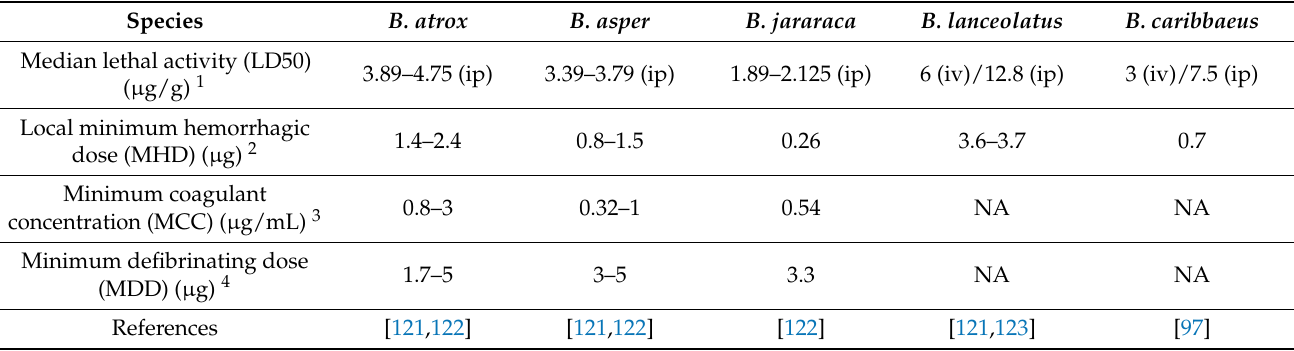
Table 3. Lethal and hemostatic activities of Bothrops